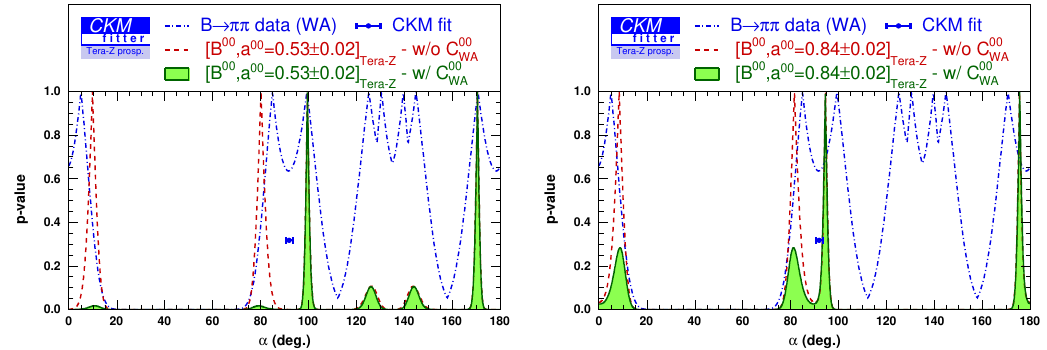
central values. CP = 0 . 840 ± 0 . 018 on the CP